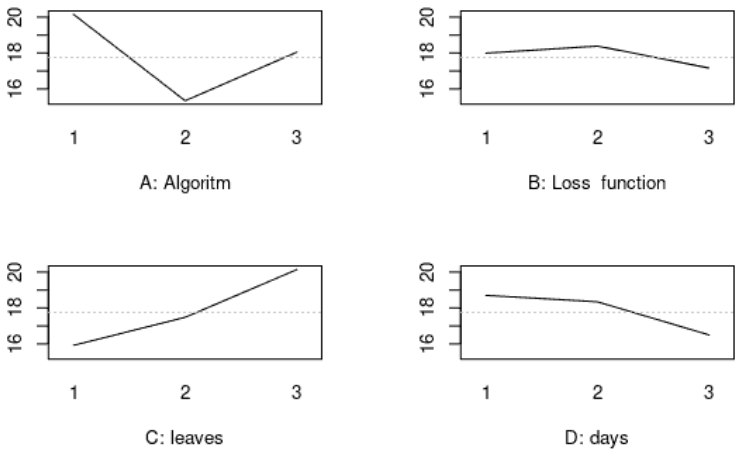
Figure 5. Ponza’s Effect Diagram.